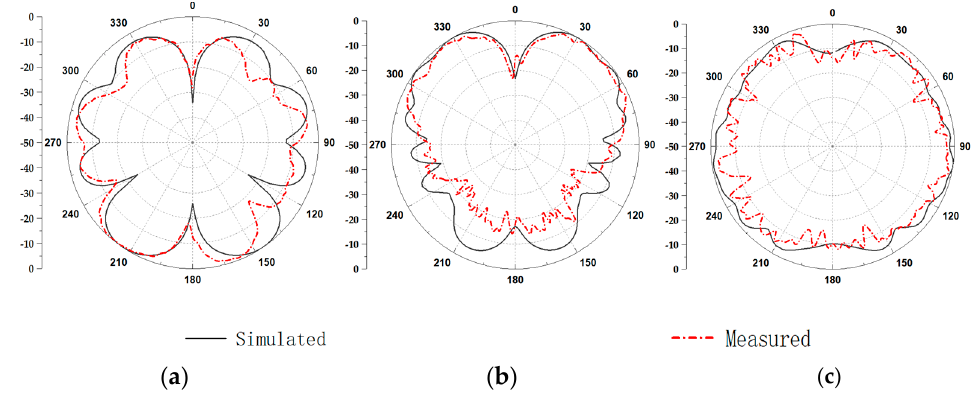
Figure 7. E-plane radiation patterns of the antenna: ( a ) 4 GHz, ( b ) 7 GHz, ( c ) 10 GHz.